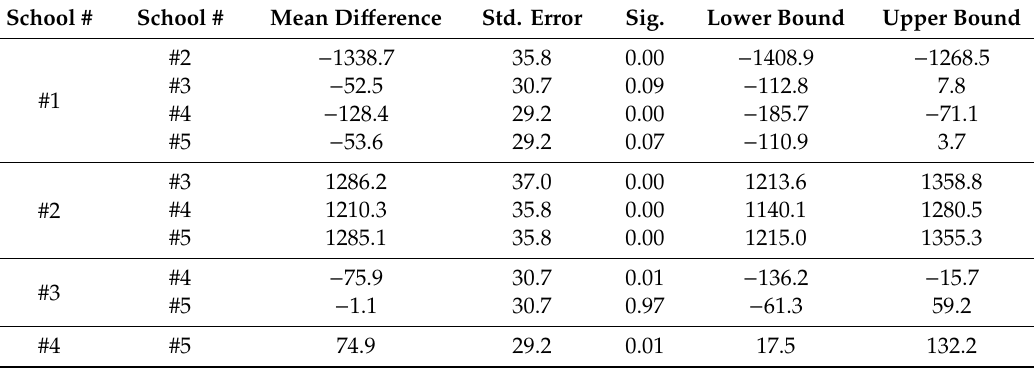
Figure 8. Classroom Illuminance Statistical Distributions by Occupancy Mode. Table 12. Fishers LSD Analysis for Classroom Illuminance by